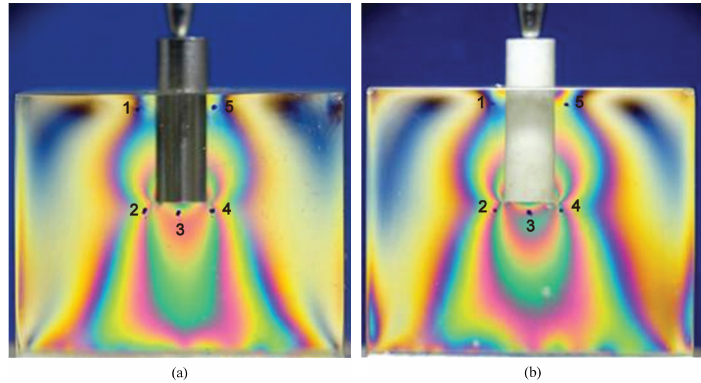
Figure 4. Comparison between photoelasticity observed in the titanium (a) and zirconia (b) cylinders under a load of 200N.